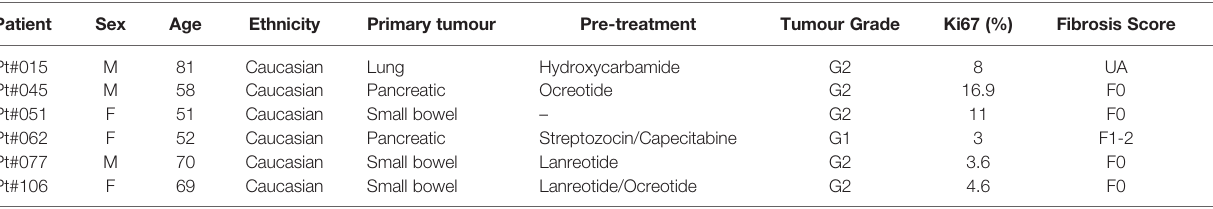
TABLE 1 | Clinical characteristics of patients recruited for PCTS